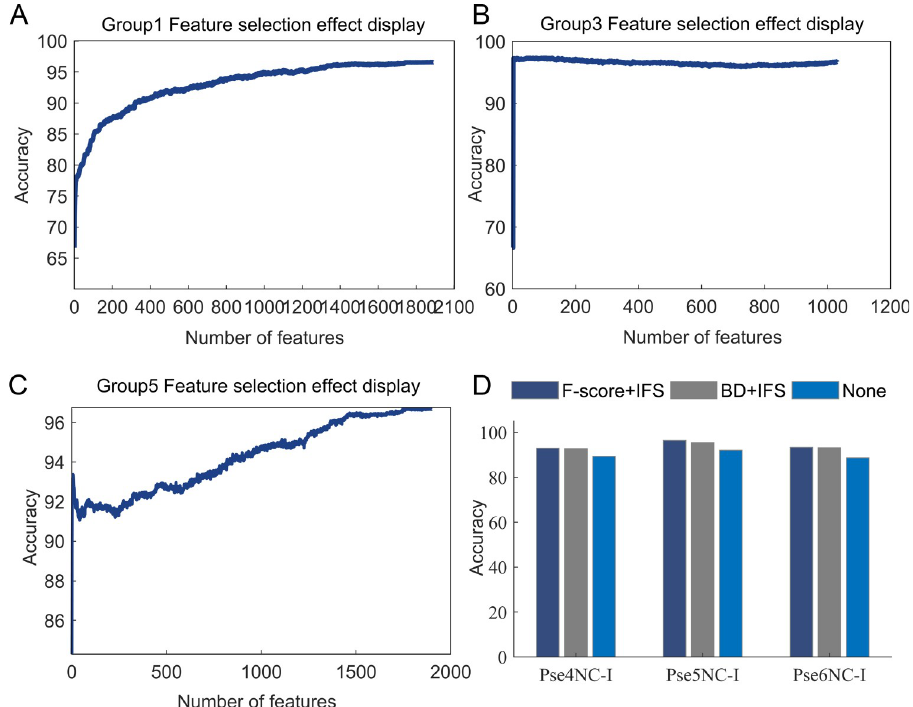
Fig 4. Performance of feature selection. (A)-(C) Relationship between the number of features and classification accuracy of three combined feature sets respectively. (D) Comparison of prediction results using three PseKNC-I features and different feature sorting methods. The combined feature set is described in detail in the next section.